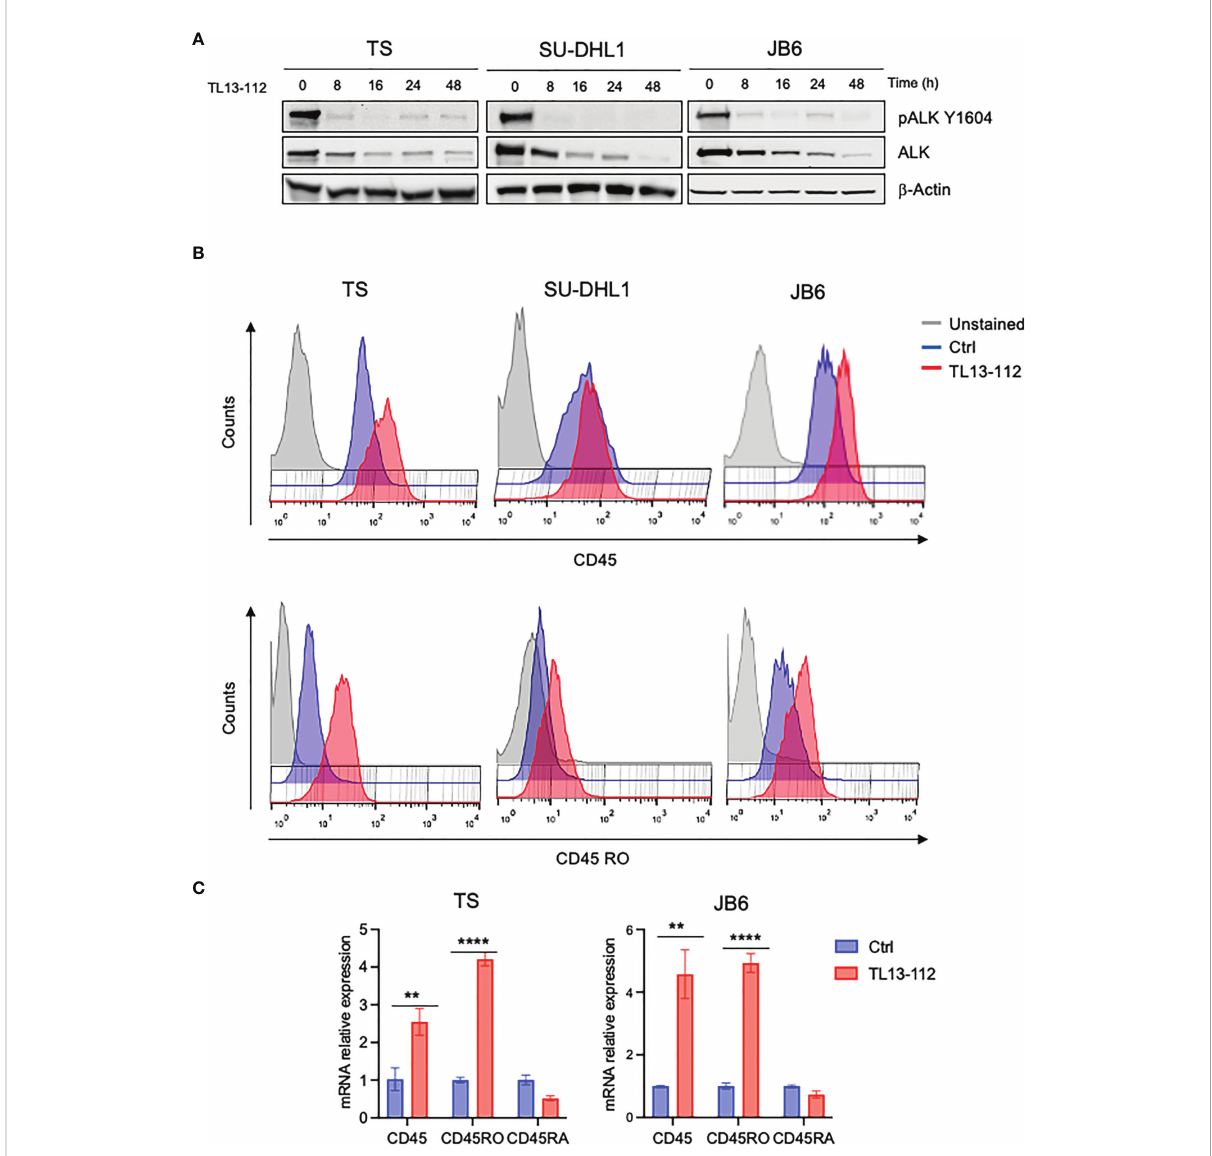
FIGURE 2 CD45 and CD45RO are derepressed by ALK degradation. (A) Immunoblot analysis of ALK+ ALCL cells (TS, SU-DHL1 and JB6) treated with ALK degrader TL13-112 (25, 10and 50nM, respectively) for the indicated time-points. Total cell lysates were blotted with the indicated antibodies. b - actin was used as a loading control. A representative Western blot out of two is shown for each cell line. (B) CD45 and CD45RO cell surface expression intensity measured by fl ow-cytometry in ALK+ ALCL cell lines treated with ALK degrader TL13-112. ALCL cells were treated with the same concentrations as in (A) for 24h (JB6) and 48h (TS and SU-DHL1). A representative experiment out of two is shown for each cell line. (C) qRT-PCR analysis of CD45, CD45RO, CD45RA mRNA expression performed on TS and JB6 ALCL cell lines treated with ALK degrader TL13-112 for 8h. n=3 technical replicates. Data are shown as mean ± s.d. **P<0.01, ****P<0.0001. Signi fi cance was determined by unpaired, two tailed Student ’ s